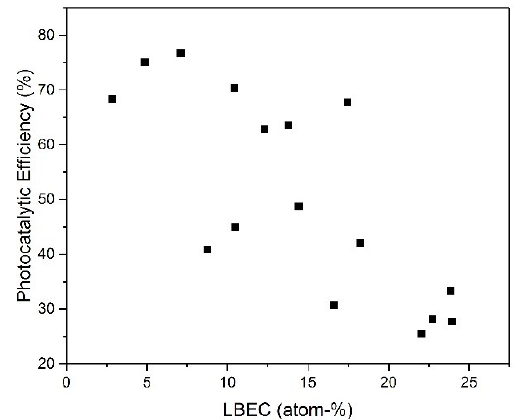
Figure 10. Atomic concentration of LBEC in atom-% vs. the photocatalytic efficiency.